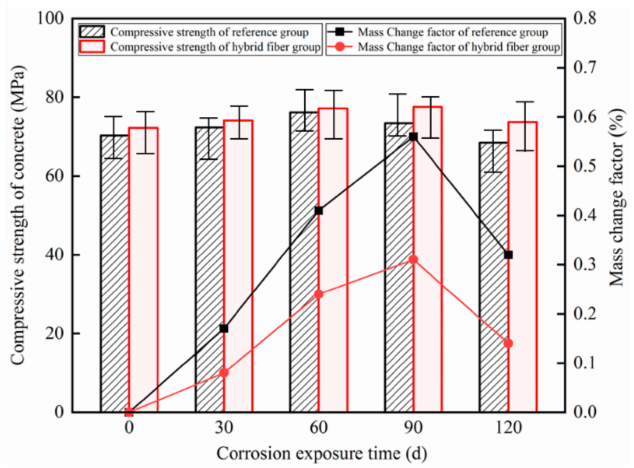
Figure 12. Relation chart of compressive strength and mass change factor with corrosion.